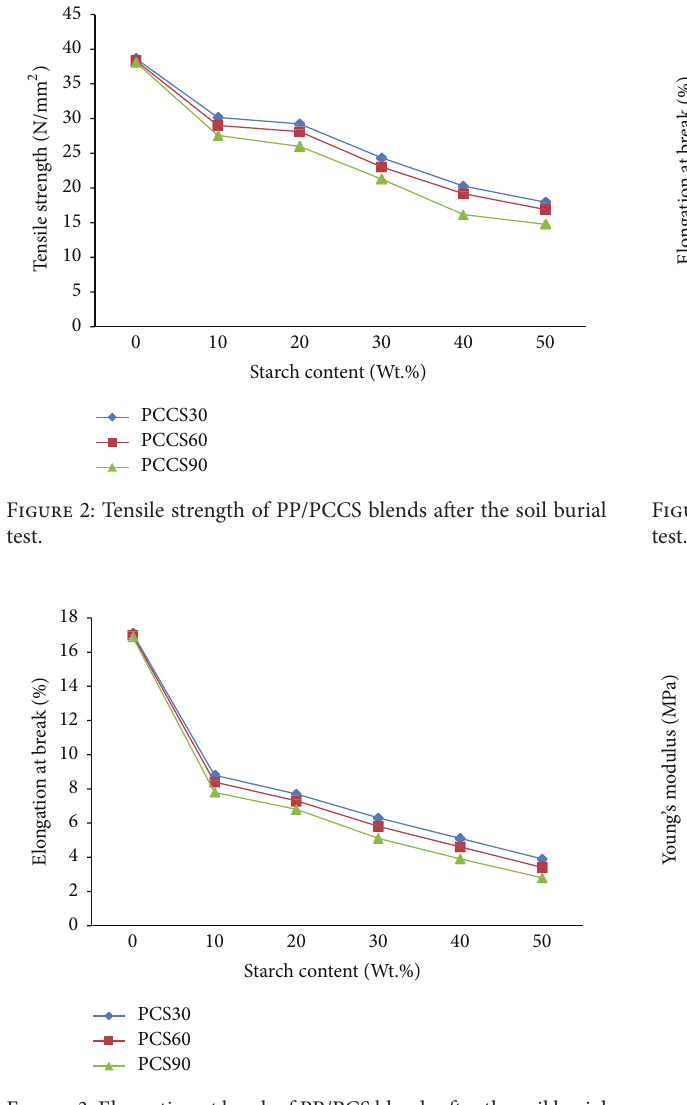
Figure 5: Young’s modulus of PP/PCS blends after the soil burial